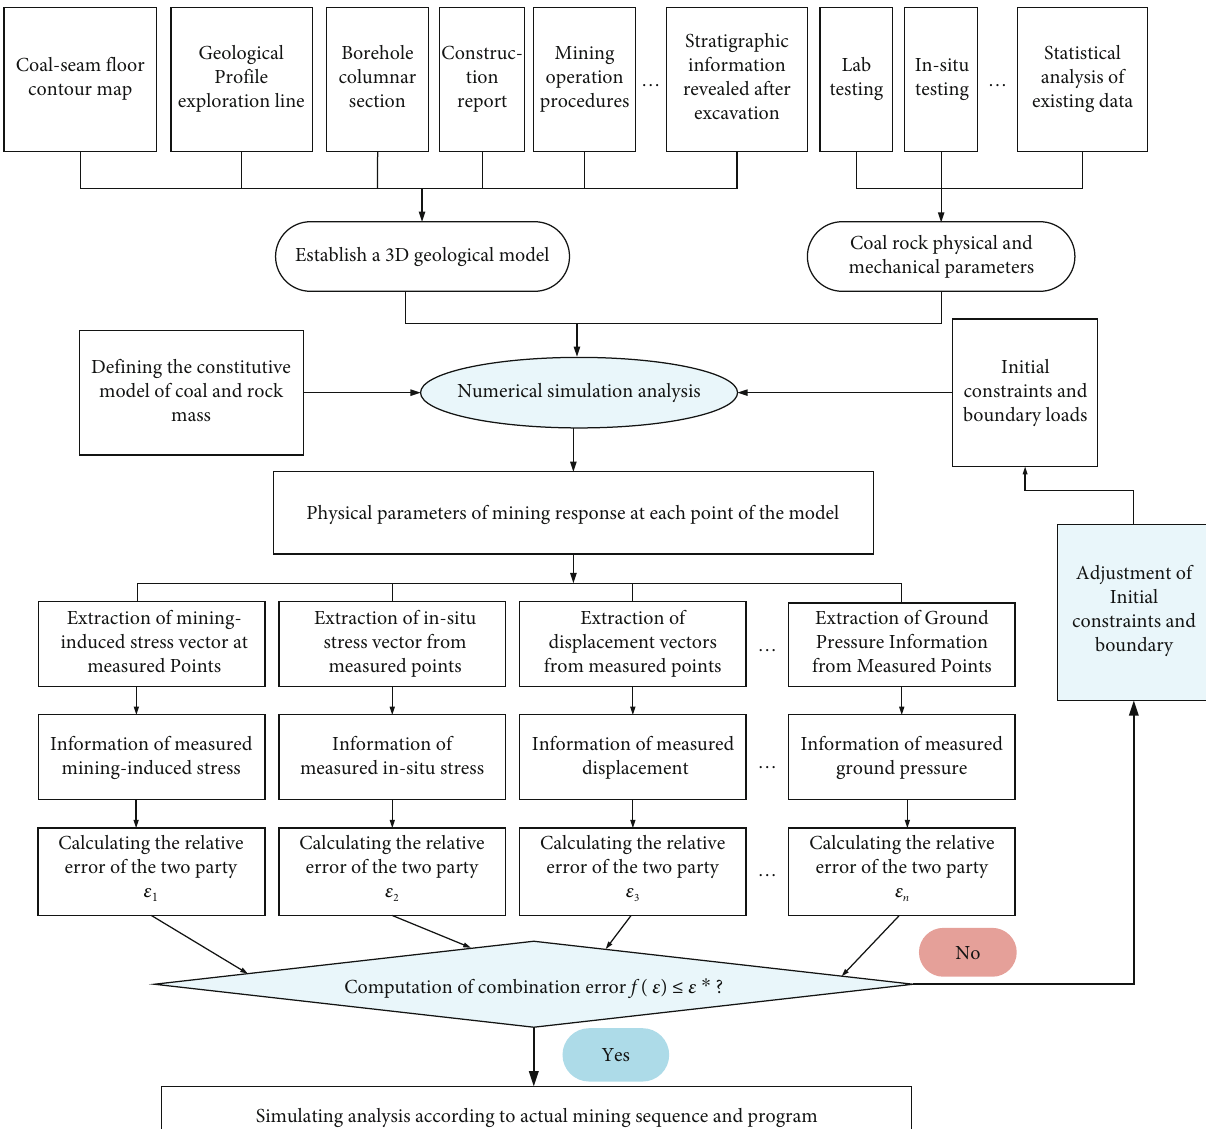
Figure 2: The adopted approach ’ s fl